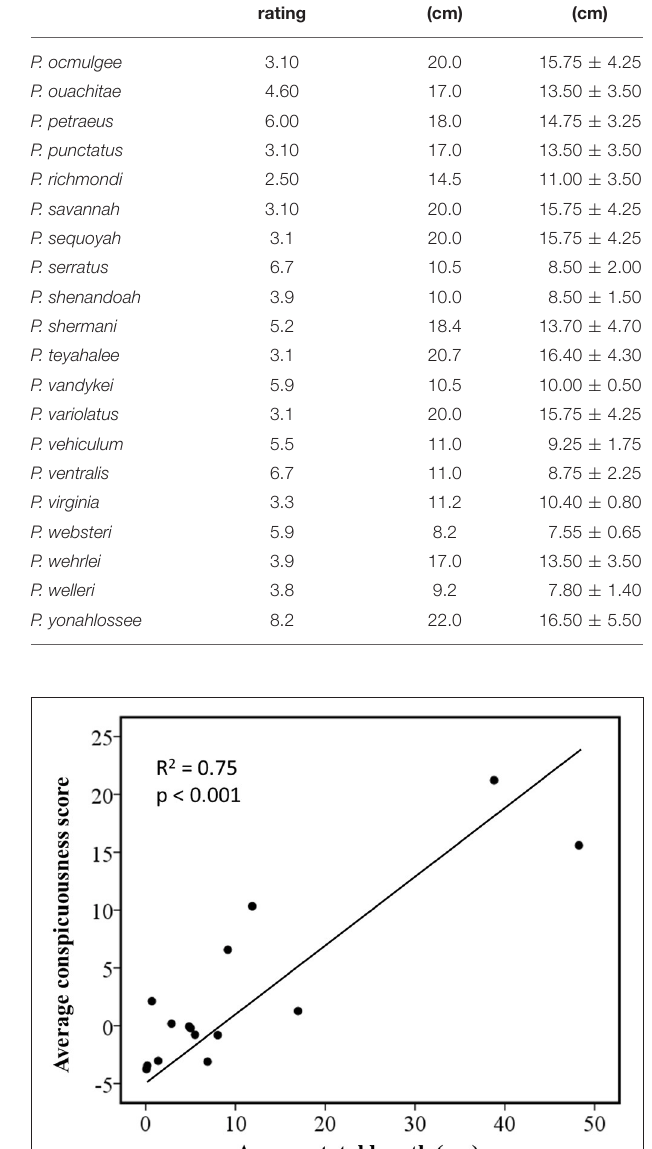
TABLE 1 | Average conspicuousness rating, maximum total length, and average total length ± 1 standard deviation for each species of Ambystoma and Plethodon .